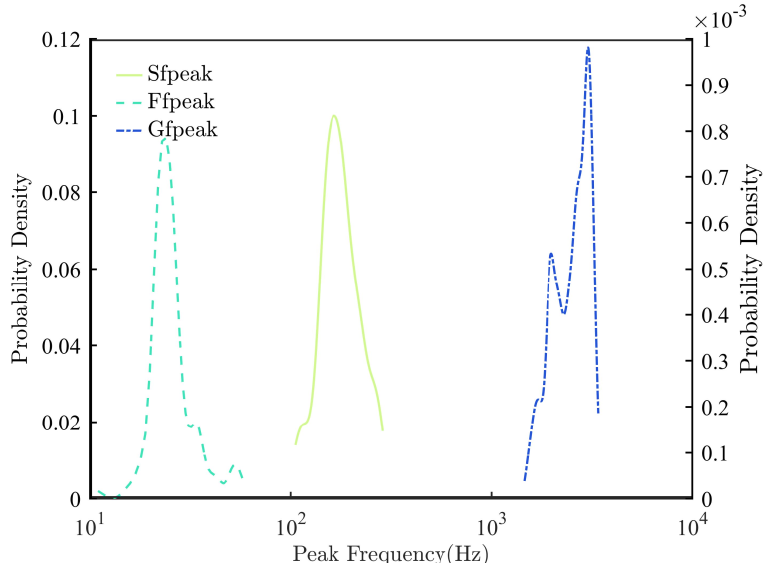
Figure 6. Probability density distribution curves of the peak frequency 𝑓 𝑝𝑒𝑎𝑘 for three types of acoustic signals. Preliminary calculations were attained by randomly extracting audio signal fragments from the original audio signal to be used as analysis samples. The curves in the image were generated by smoothing the results of the preliminary calculations to concentrate the distribution.